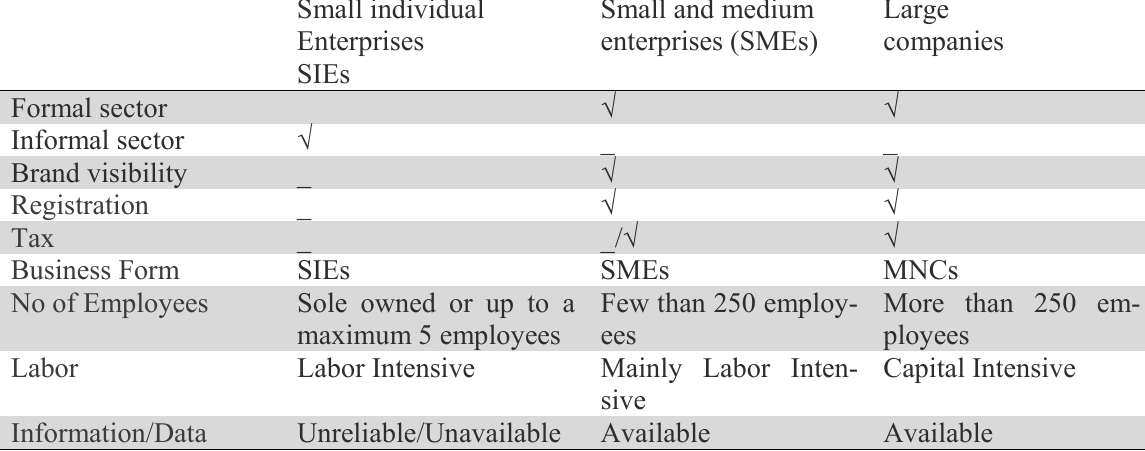
The unique characteristics of SIEs against SMEs and large companies Small individual Small and medium Large Enterprises enterprises (SMEs) companies SIEs Formal sector √ √ Informal sector √ _ _ Brand visibility _ √ √ Registration _ √ √ Tax _ _/ √ √ Business Form SIEs SMEs MNCs No of Employees Sole owned or up to a Few than 250 employ- More than 250 em- maximum 5 employees ees ployees Labor Labor Intensive Mainly Labor Inten- Capital Intensive sive Information/Data Unreliable/Unavailable Available